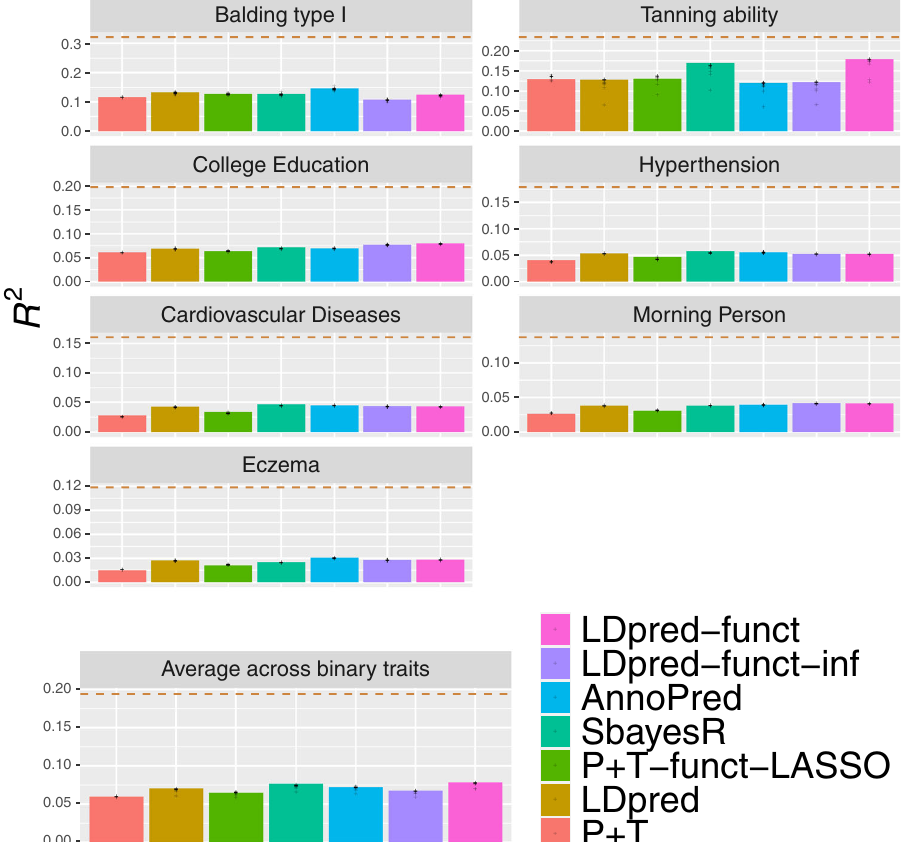
Fig. 3 Accuracy of 7 polygenic prediction methods across 7 UK Biobank binary traits. We report results for P + T, LDpred, SBayesR, P + T-funct-LASSO, AnnoPred, LDpred-funct-inf and LDpred-funct. Dashed lines denote estimates of SNP-heritability. Numerical results are reported in Supplementary Table 15. Data points represent the prediction accuracy values obtained via block-jacknife over 200 genomic blocks. Source data are provided as a Source Data fi